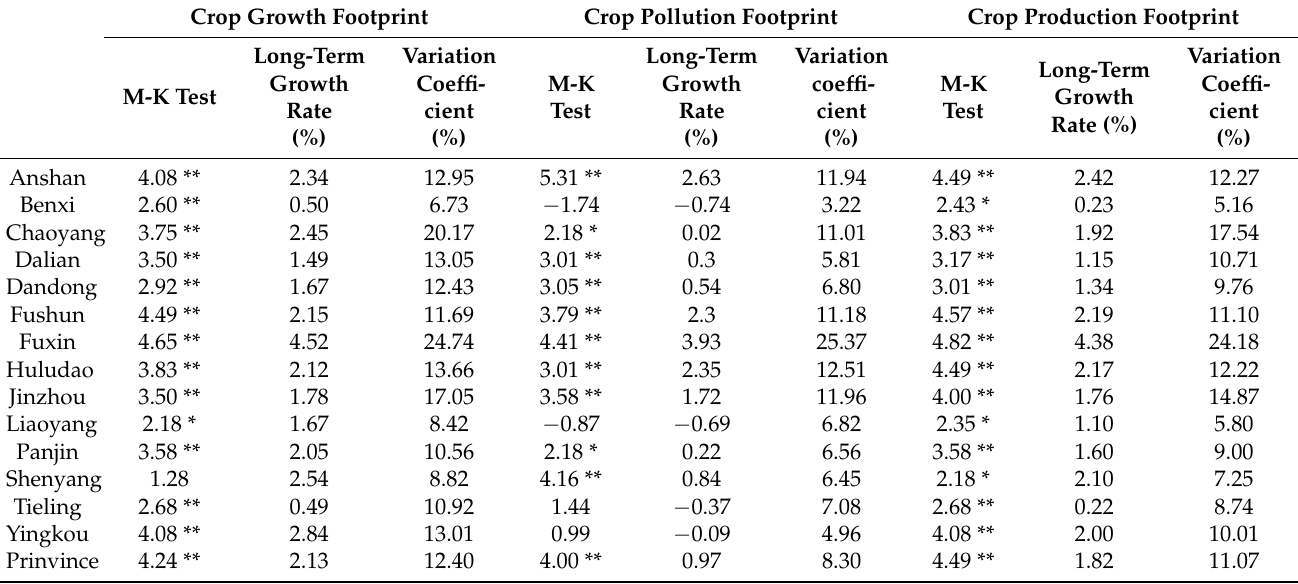
Table 1. The variation coefficient and M-K test of crop water footprint of every city in Liaoning